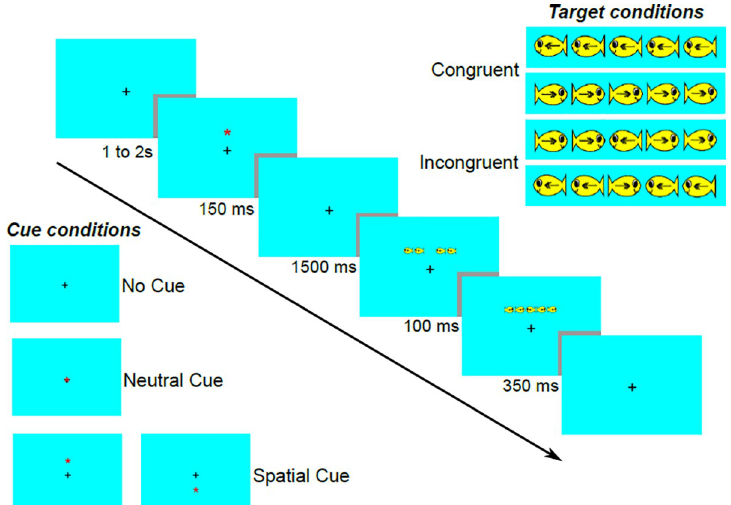
Fig 1. Sequence and duration of signals in an Attention Network Test trial. Arrow: time axis with signal duration (ms); black cross: fixation point; red star: cue signal; central yellow fish: target signal; lateral pairs of yellow fishes: